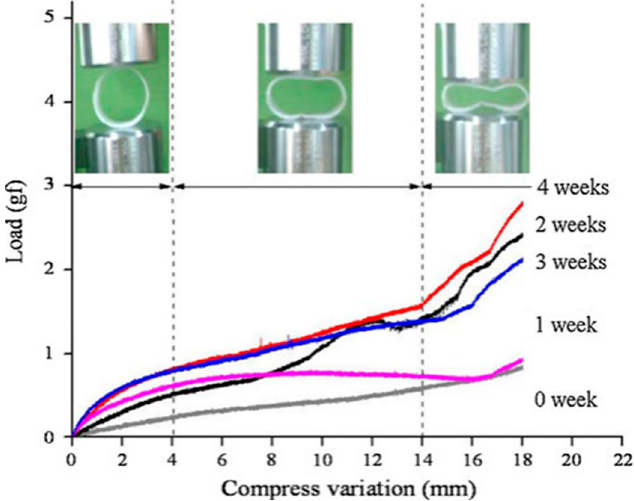
Figure 2. Influence of in vitro degradation time on anti-compressproperty of PCLA ring and